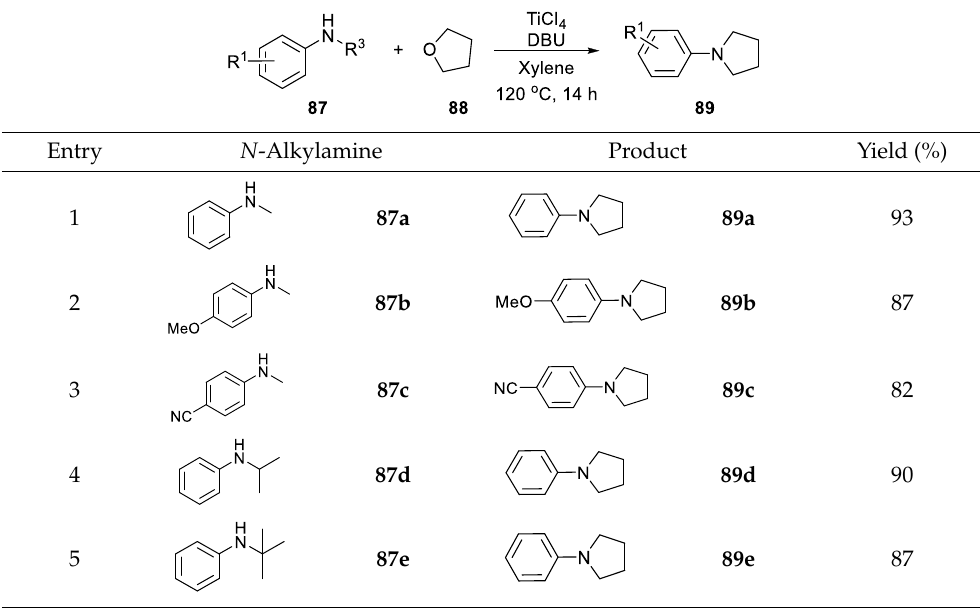
Table 2. Synthesis of N -aryl azacycles from various N -alkyl amines and THF.